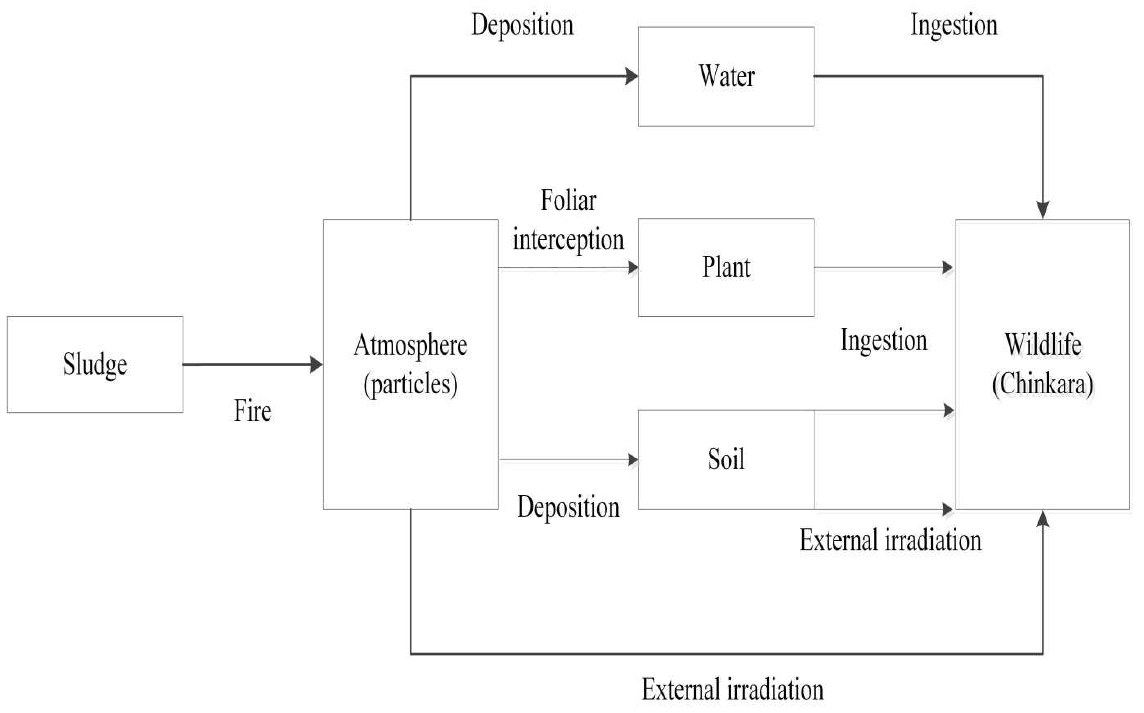
Figure 1. Conceptual assessment model of sludge burning